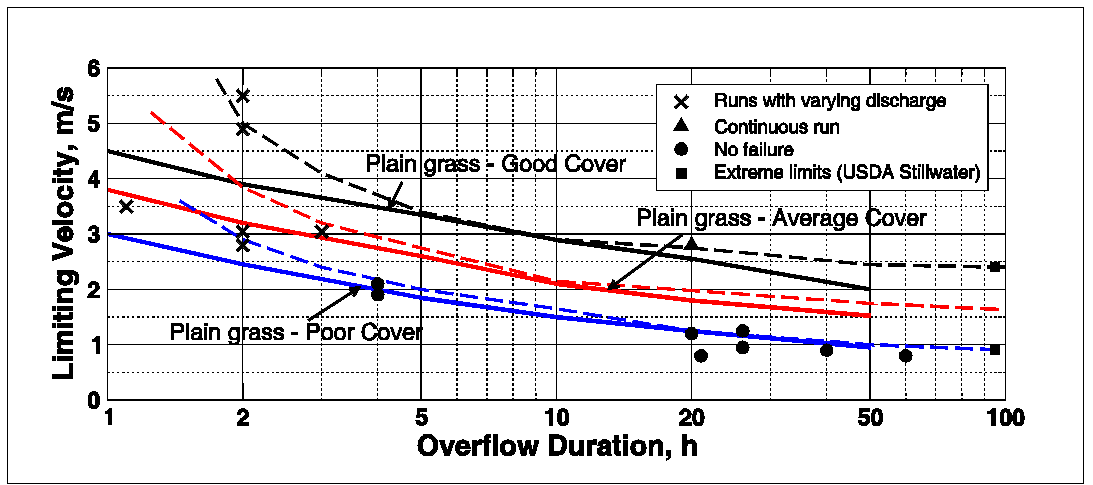
Figure 2. Erosion resistance of grass-lined spillways (after Whitehead et al.